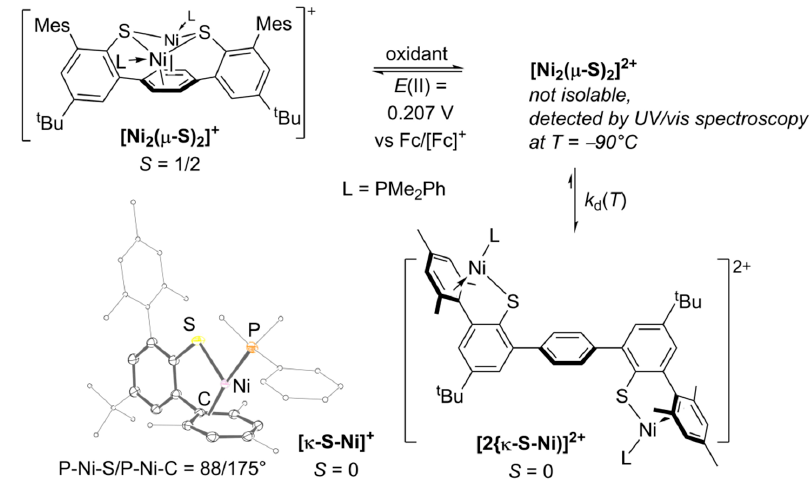
Figure 3. Preparation and molecular structure of bimetallic [2{ κ -S–Ni}] 2+ , and molecular structure of mononuclear reference complex [ κ -S–Ni] + ; alternatively, 2Ni–2S can substitute [Ni 2 ( µ -S) 2 ] + as starting material; N(SO 2 CF 3 ) 2 counteranions, and H-atoms in ORTEP representation of [ κ -S–Ni] + omitted for clarity; oxidant = 1,1 (cid:48) -diacetylferrocenium–N(SO 2 CF 3 ) 2 or 1:2 equivalents mixture of benzoquinone and HN(SO 2 CF 3 ) 2 ; Fc =